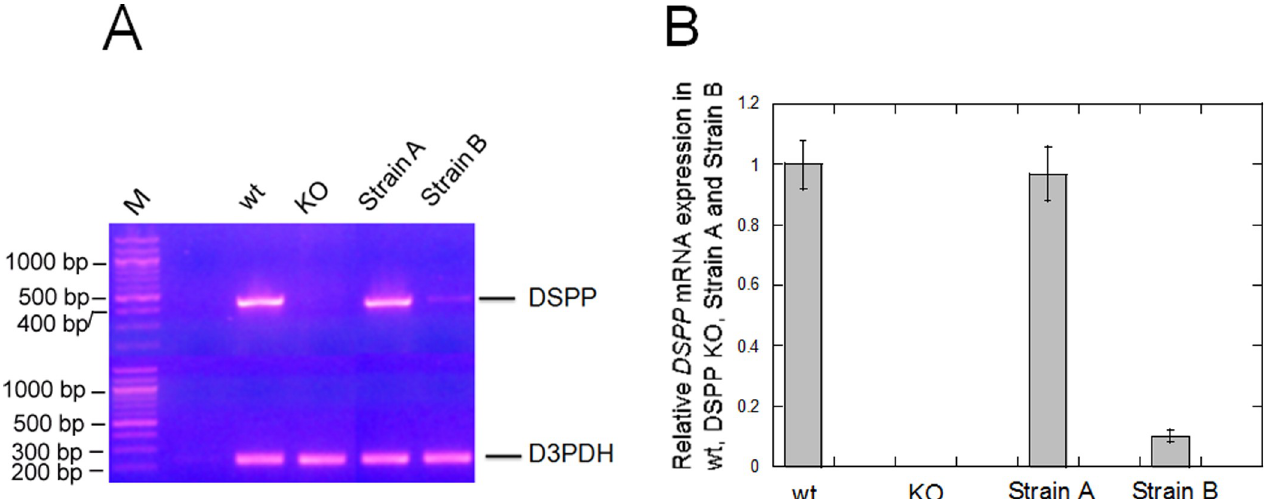
Fig 2. Examination of DSPP mRNA expression in wt, DSPP KO, BAC-DSPP transgene Strain A and Strain B teeth. (A) A Thermo Scientific Verso cDNA kit was used to generate cDNA pools from wt, DSPP ko, Strains A and B incisor total RNAs. These cDNA pools were used to perform 30 cycles of polymerase Chain Reactions. Using a pair of PCR primers for DSPP cDNA, a 441 bp DSPP DNA band was detected in wt teeth but was not detected in DSPP KO teeth. A 233 bp glyceraldehyde-3-phosphate dehydrogenase (GAPDH) band was detected in both wt and DSPP KO teeth. (B) Using NIH image J, we determined the relative expression of normalized DSPP mRNA and present a graph of the relative expression of DSPP